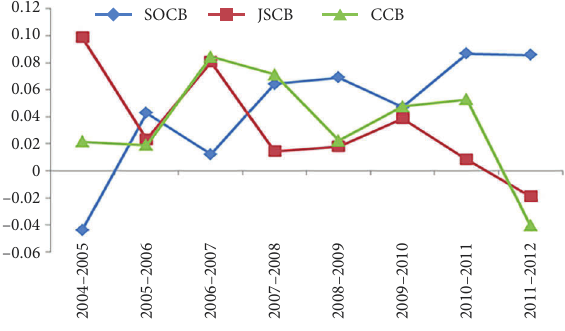
Figure 7. SEC trends of three types of banks: 2004–2012